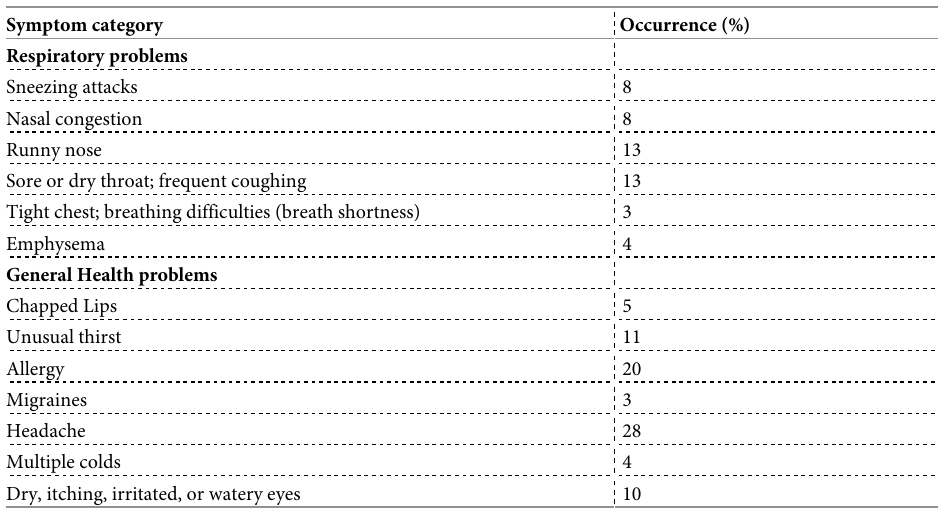
Table 2. Prevalence of the reported health effects/symptoms due to indoor air quality.